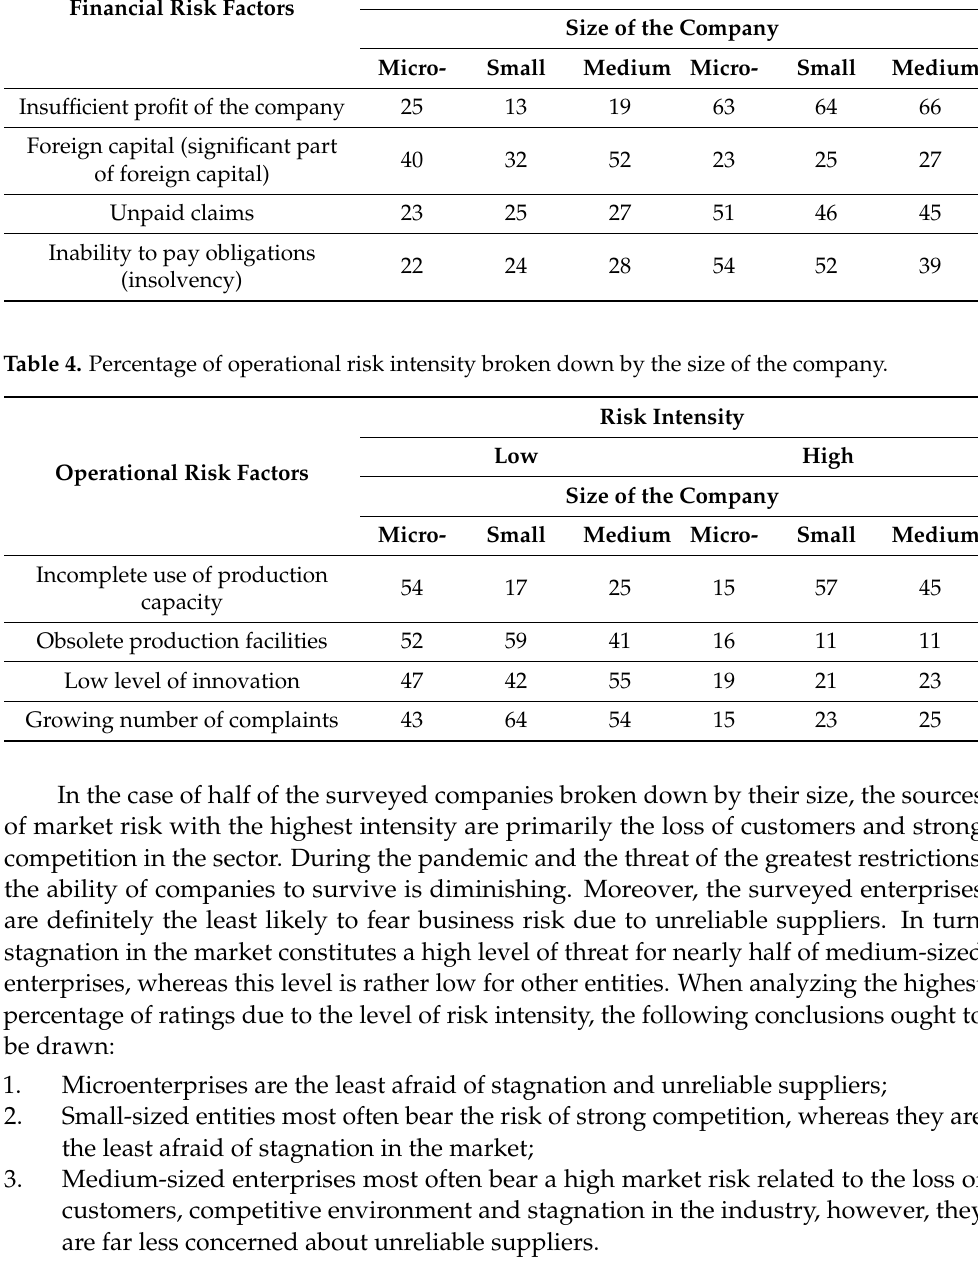
Table 3. Percentage of financial risk intensity broken down by the size of the company. Risk Intensity Low Low Financial Risk Factors Size of the Company Micro- Small Medium Micro- Small Insufficient profit of the company Foreign capital (significant part of foreign capital)